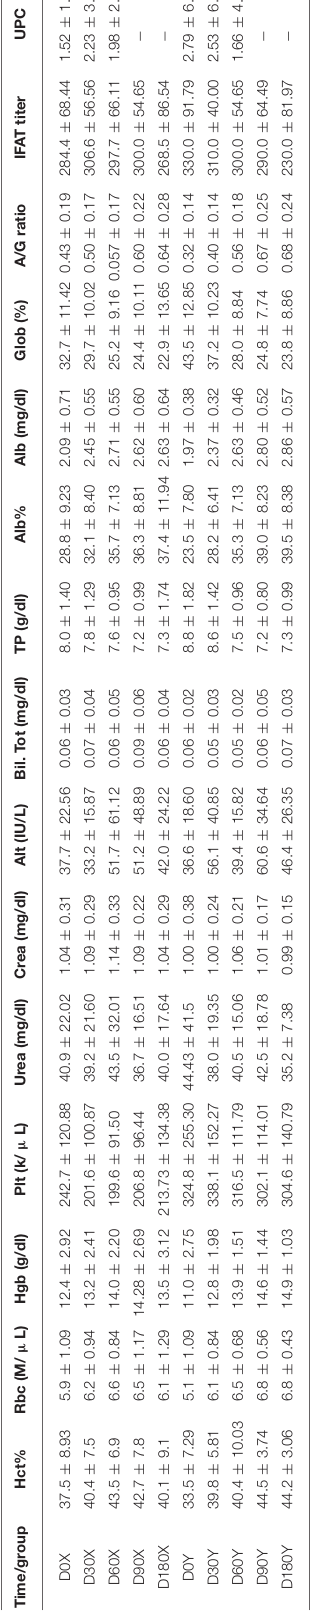
TABLE 3 | Leishmania DNA load in Group X and Group